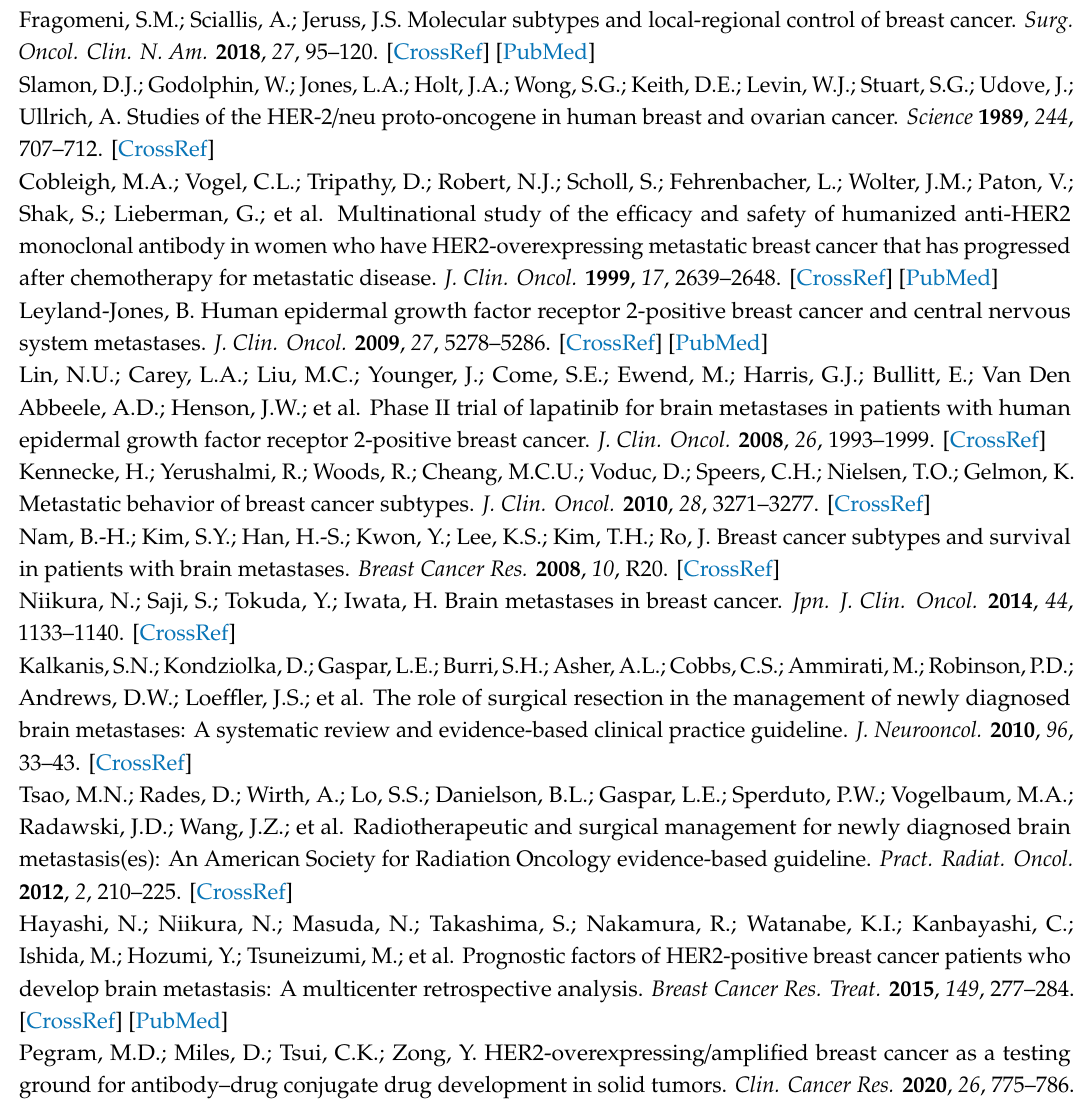
cell lines., Figure S5: Western blotting of three original HER2-positive breast cancer cell lines and their derivatives that survived in the brain tissue.; Table S1: The intensity of bioluminescence per 1 × 10 5 cells in vitro.; Table S2: Gene expression profile of nine HER2-positive breast cancer cell lines.; Table S3: Genes that are mutated in the RG but not in the